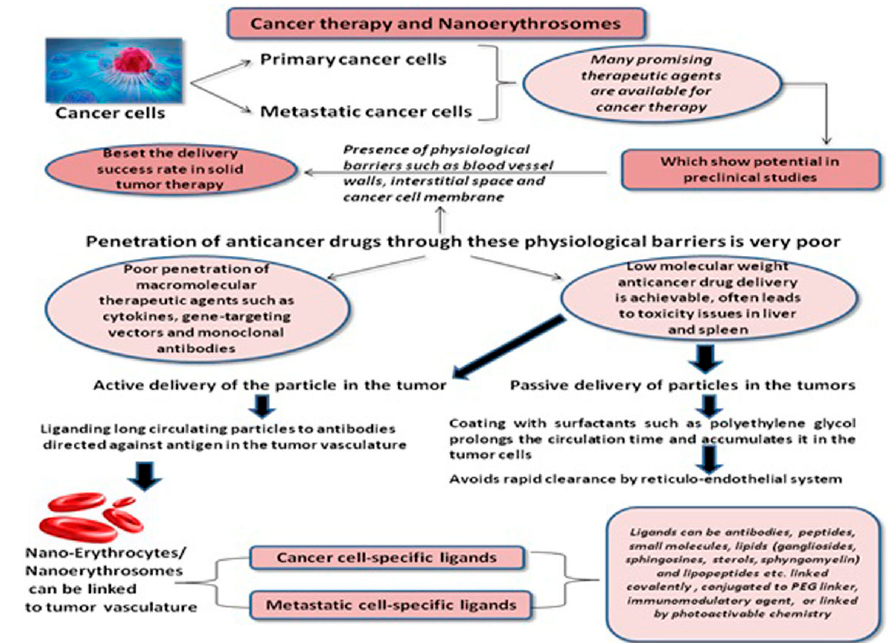
Figure 2. Role of NERs in cancer therapy.